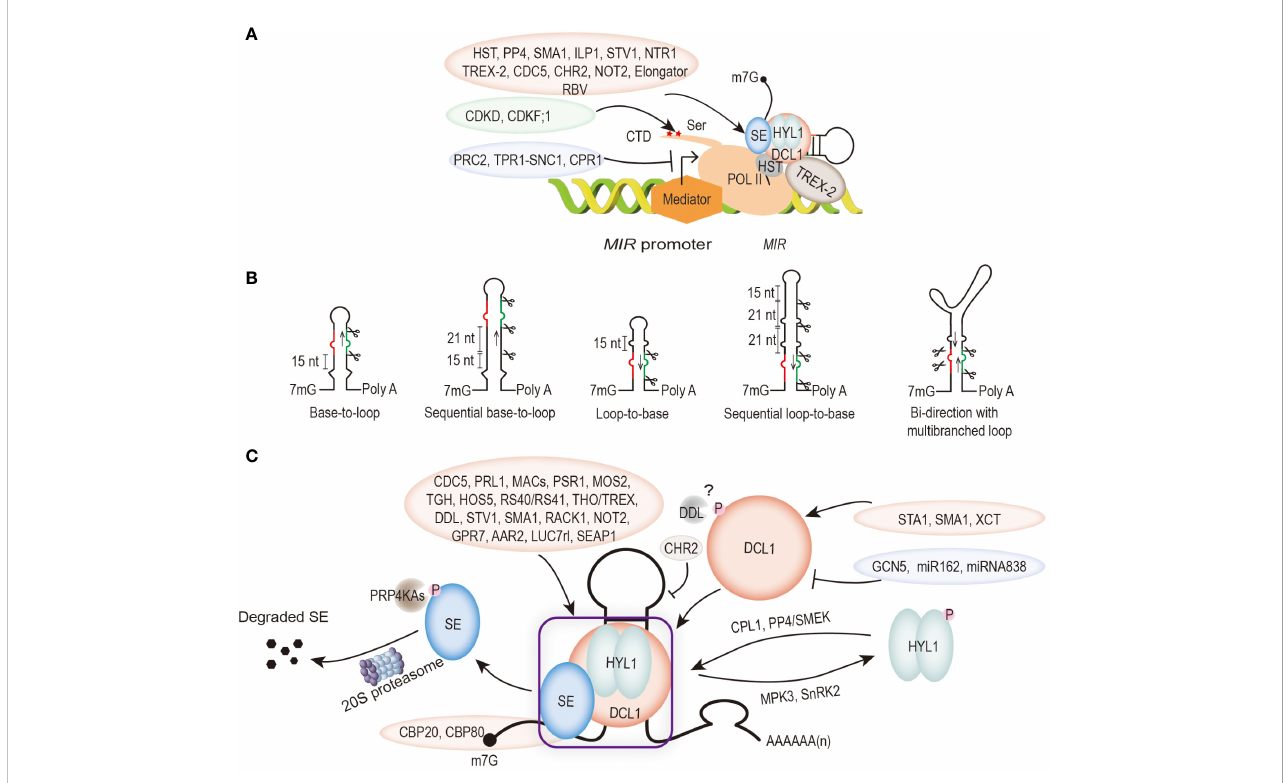
FIGURE 2 Diagram of the principal steps in microRNA (miRNA) biogenesis. Positive and negative modulators are marked with light pink and light purple ellipses, respectively. (A) Regulation of MIR transcription. Multiple transcription regulators are required to regulate POL II-mediated MIR transcription. The activity of POL II is also regulated by phosphorylation of its C-terminal structural domain (CTD). (B) Structures of pri-miRNAs affect their processing patterns. DCL1 recognizes a small bulge near the base of the stem-loop secondary structure of pri-miRNA. Base-to-loop or sequential base-to-loop processing of pri-miRNAs. Some pri-miRNAs are cut fi rst at ∼ 15 nt distal to the loop to release miRNA/miRNA* duplex, but some pri-miRNAs with long stems are initially cut at 15 nt distal to the loop, and each subsequent cut is ∼ 21 nt to release miRNA/miRNA*. Loop-to-base or sequential loop-to-base processing pattern of pri-miRNAs. DCL1 recognizes a small loop at the end of the stem, and cut at 15 nt toward the base of the stem. Some pri-miRNAs with long stem loops are processed through multiple cleavages from the proximal to the loop at 21 nt intervals. Bidirectional processing of pri-miRNAs with a multibranched terminal loop. (C) Regulation of pri-miRNA processing. Processing pri-miRNAs require the use of core dicing bodies (DCL1, SE, and HYL1) as well as several other accessory components. The abundance and activity of DCL1, SE, and HYL1 are regulated by several protein factors and miRNAs. Core microprocessor of phosphorylation status affects the ef fi ciency of pri-miRNA processing. Phosphorylation of SE mediated by PRP4KAs and followed be degraded by the 20S proteasome. CBP80 and CBP20 are subunits of the nucleocapsid binding complex (CBC), which interact with SE. They bind to the m 7 G cap structure of the 5 ’ end pri-mRNA to prevent degradation. The phosphorylation of DCL1 is mediated by DAWDLE (DDL) to affect pri- miRNA processing. The dephosphorylated and phosphorylated forms of HYL1 are mediated by a series of phosphatases (CPL1, PP4/SMEK) and kinases (MPK3 and SnRK2). In addition, the microprocessor can be synergized by many proteins to promote pri-miRNA processing (marked with light pink ellipse), while CHR2 inhibits its